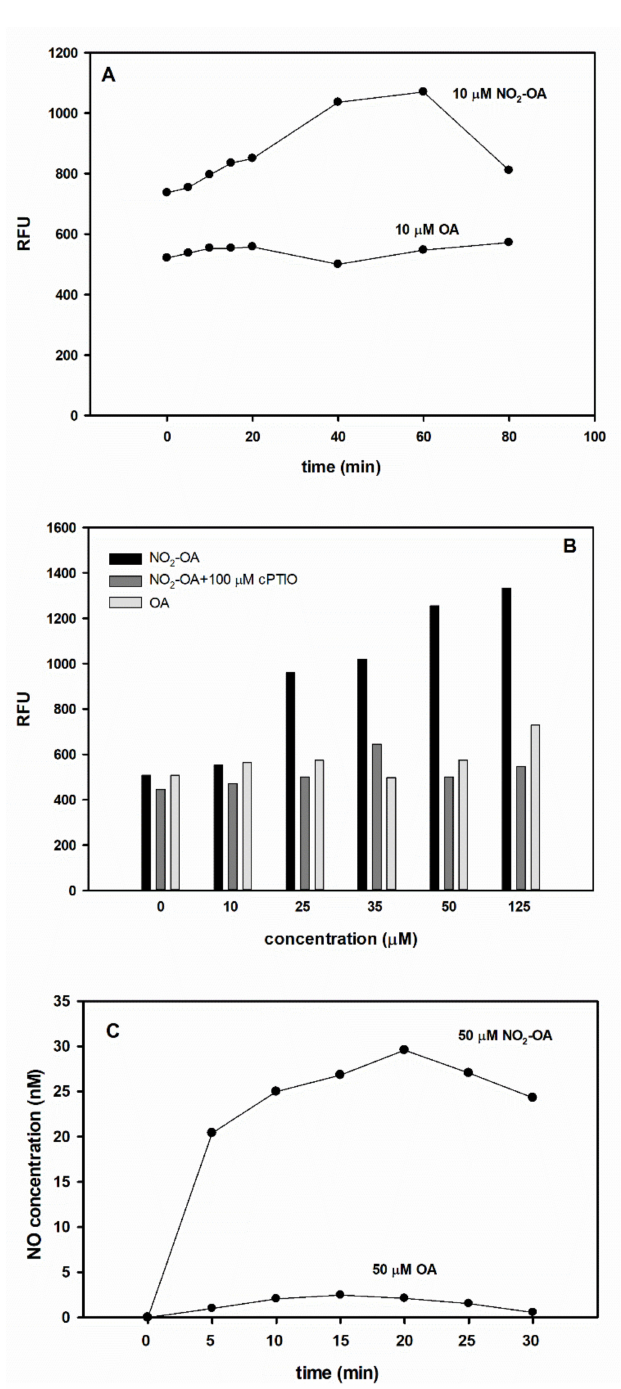
Figure 6. NO 2 -OA liberates • NO in solutions ( A ) Relative fluorescence units (RFU) of DAF-FM fluorescence in solutions in the presence of 10 µ M NO 2 -OA or 10 µ M OA measured at di ff erent time points. ( B ) Relative fluorescence units (RFU) of DAF-FM fluorescence in solutions containing di ff erent concentrations of NO 2 -OA (with or without 100 µ M cPTIO) or OA. Data were recorded after 20 min incubation. ( C ) • NO concentration (nM) measured by ISO-NOP (2 mm) electrode in solutions containing 50 µ M NO 2 -OA or OA measured at di ff erent time